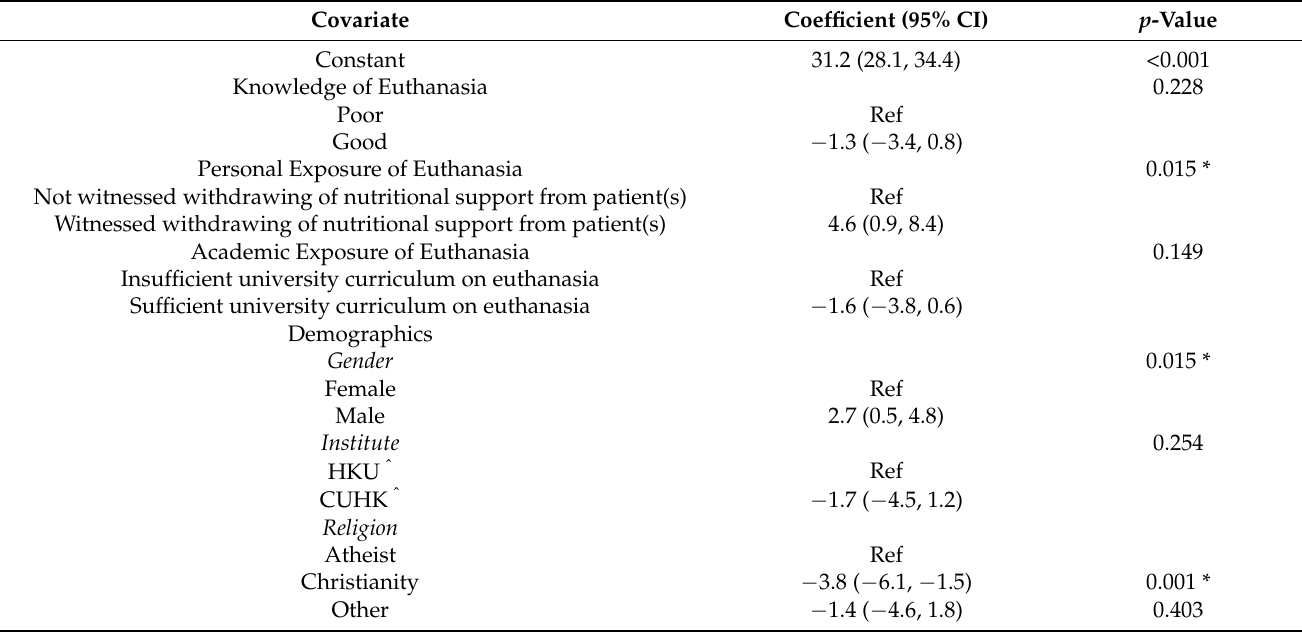
Table 3. Multiple Linear Regression of different factors associated with the ATE score (demographics adjusted) ( n = 228). Covariate